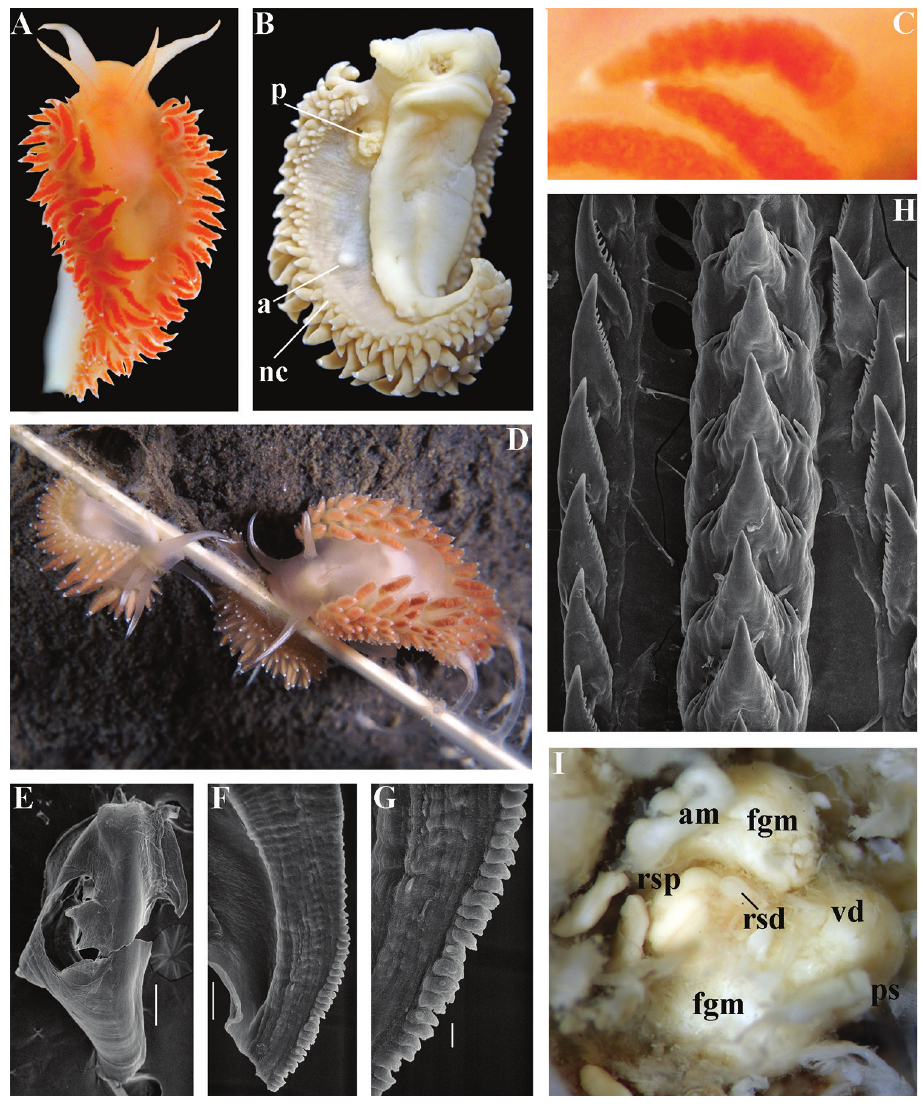
Figure 25. Gulenia borealis (Odhner, 1922), comb. n. GNM Gastropoda 9417, 11 mm length (fixed), Norway ( A–C, E–I ), Sweden ( D ): A dorsal view (live) B ventro-lateral view (fixed) C details of cerata D living animals in situ on Funiculia (Pennatulacea) E jaw, SEM F , G details of masticatory process of jaw, SEM H radular teeth, posterior part I reproductive system. Abbreviations: a anus am ampulla fgm female gland mass nc continuous notal edge p penis ps penial sheath rsd distal receptaculum seminis rsp proximal receptaculum seminis vd vas deferens (muscular part). Scale bars: E = 300 μm; F = 30 μm; G = 10 μm; H = 100 μm. Photos of living specimens by T. Cedhagen ( A ), and K. Malmberg ( D ), SEM images by A.V.